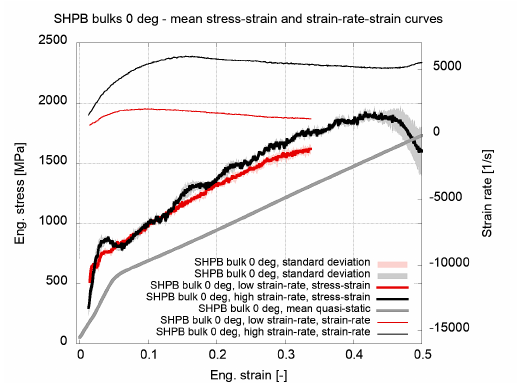
Figure 8. Mean results for the specimens printed at the angle of 0°